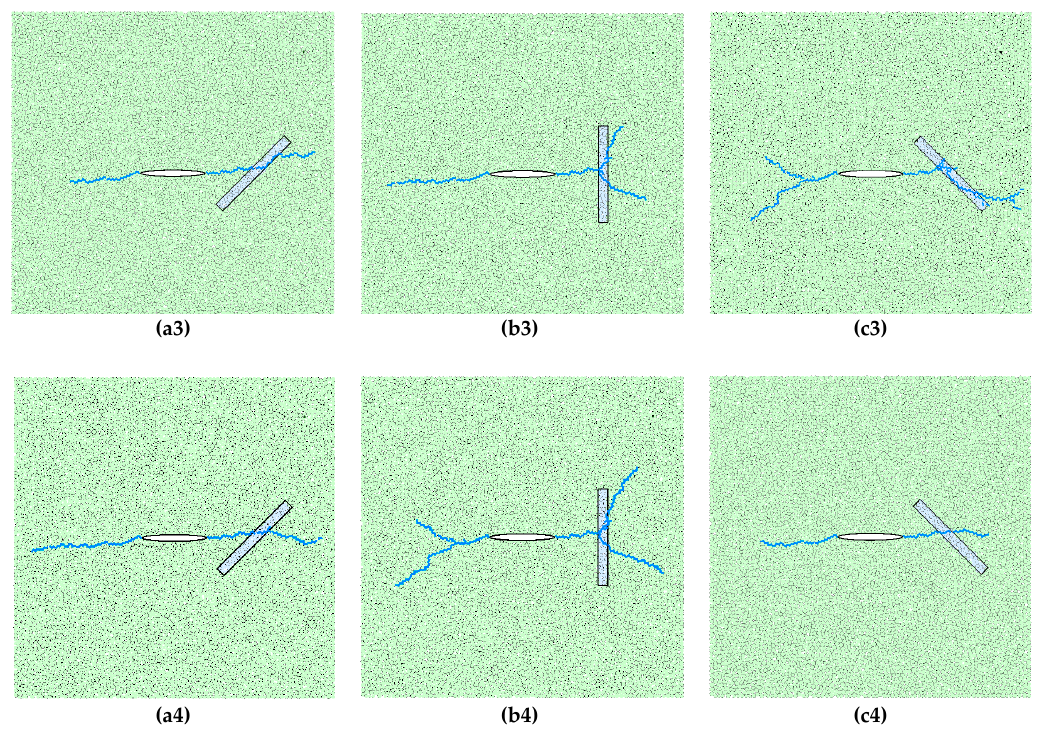
Figure 9. HF and WP interaction modes under different fluid pressure: ( a1 ) 7.40 MPa ‐ Arr; ( a2 ) 7.75 Figure 9.